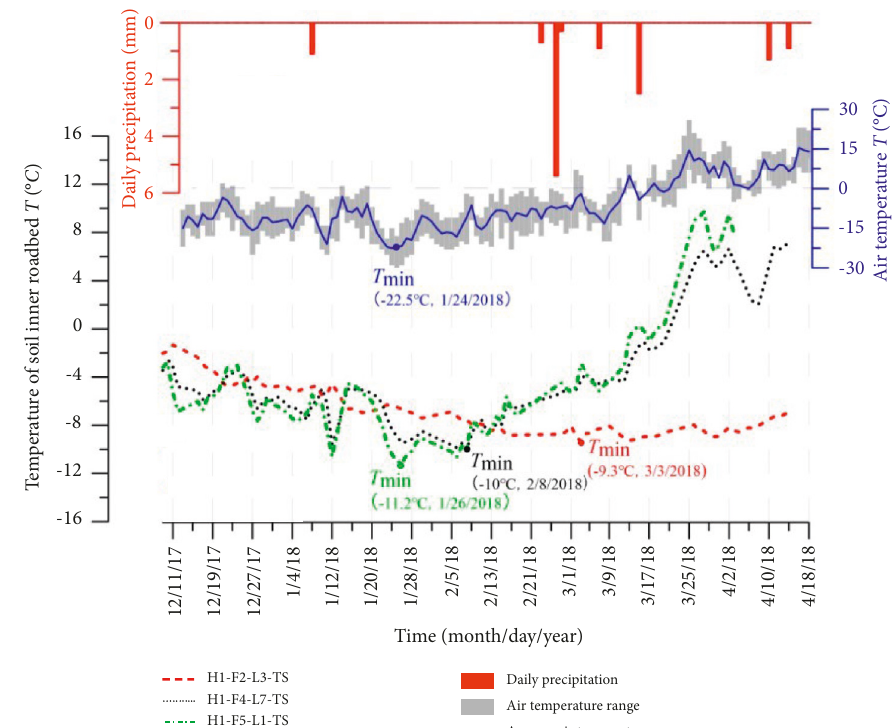
Figure 8: Curves of soil temperature in the F5, F4, and F2 layers of the roadbed under climatic conditions.